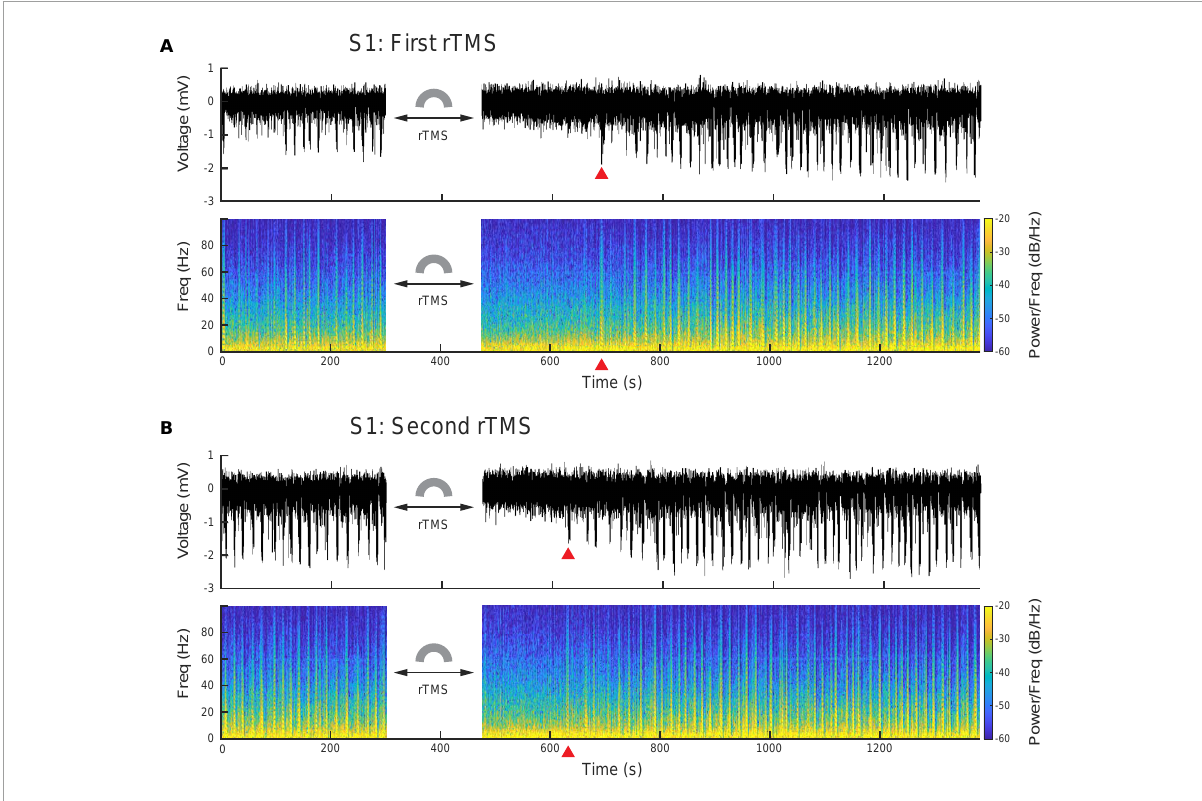
FIGURE6 PPS were effectively and reversibly suppressed by rTMS. (A) Wideband signal and its spectrogram before and after the first course of rTMS. (B) Wideband signal and its spectrogram before and after the second course of rTMS. Red triangles denote the first PPS occurred after rTMS.